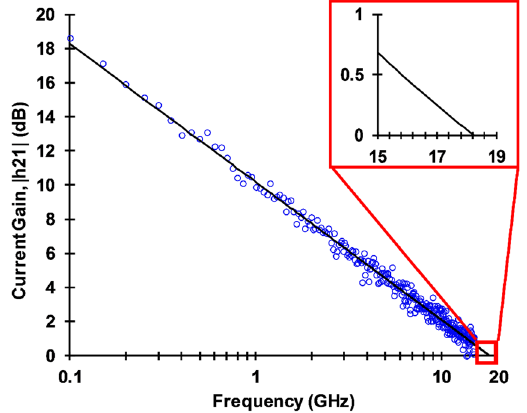
Figure 5. ( a ) De-embedded current gain with an intrinsic f t of 18.21 GHz. ( b ) Detail showing point where H 21 =